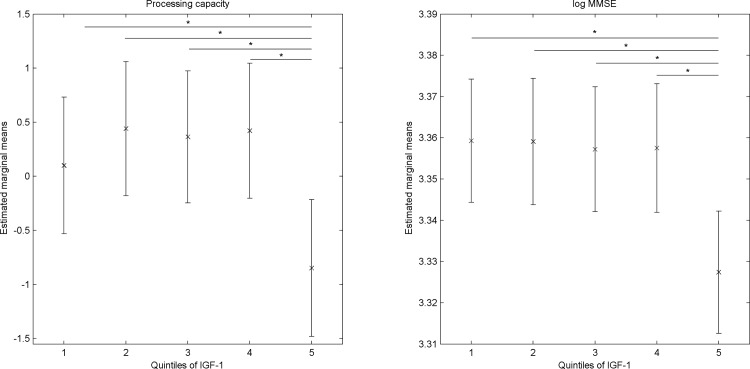
Mean performance in cognitive domains at follow-up for quintiles of IGF-1 in complete case dataset (adjusted for cognitive scores at baseline, age, education level, BMI, smoking, physical activity, and glucose levels.Error bars indicate 95% confidence intervals of the adjusted mean cognitive score. Higher values on y-axis represent better cognitive performance. Sample size in each quintile: Q1 = 53, Q2 = 53, Q3 = 56, Q4 = 52, Q5 = 51. * indicates significant at a p value of < .05).